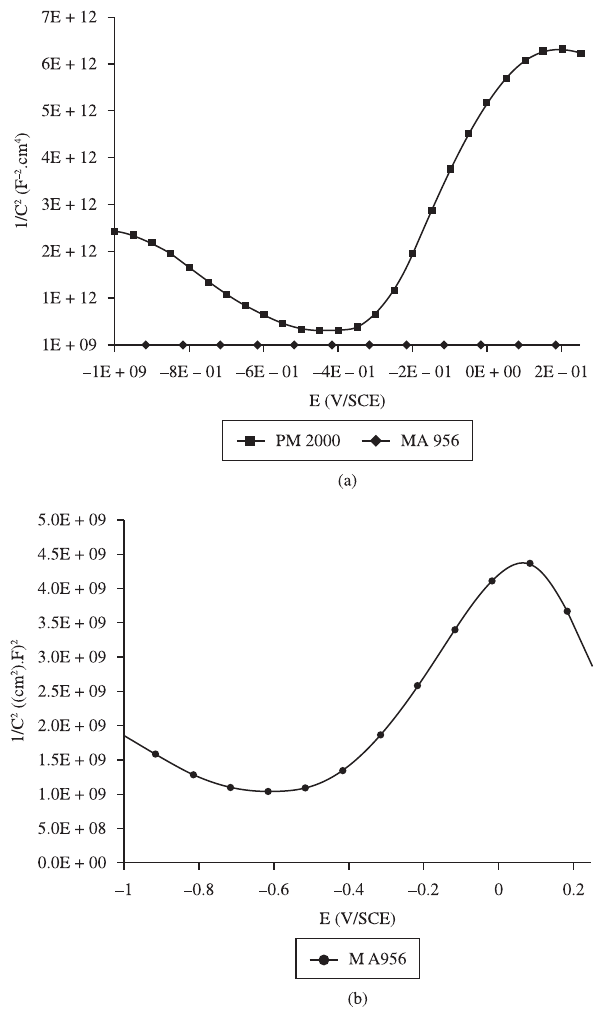
Figure 6. Mott-Schottky approach for the PM 2000 and MA 956 after 2 days of immersion in a PBS solution at 25 °C. whereas the PM 2000 only showed large current increase typical of film breakdown at potentials of approximately 1.2 V . The increase SCE in current density at this last potential could be due to the oxygen evolution reaction instead of pitting. The samples were analyzed by scanning electron microscopy (SEM) after anodic polarization tests to investigate whether pits were formed on the alloy surface. Figure 4 shows the surfaces of both alloys after have been